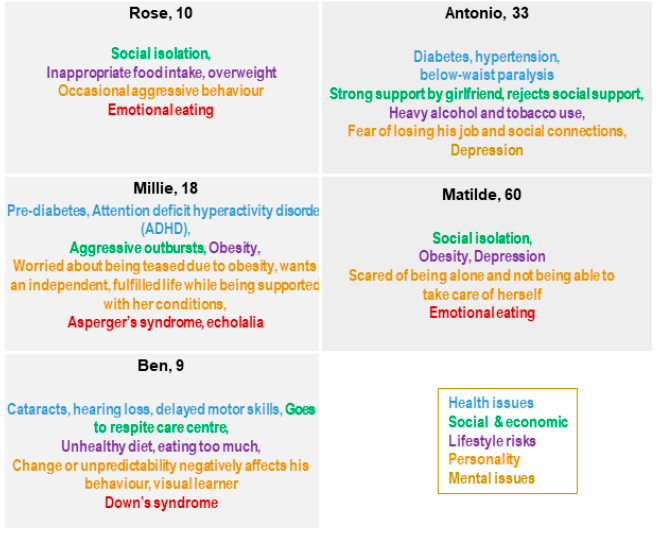
Figure 2. Rose, Millie, Ben, Antonio, and Matilde and their key points